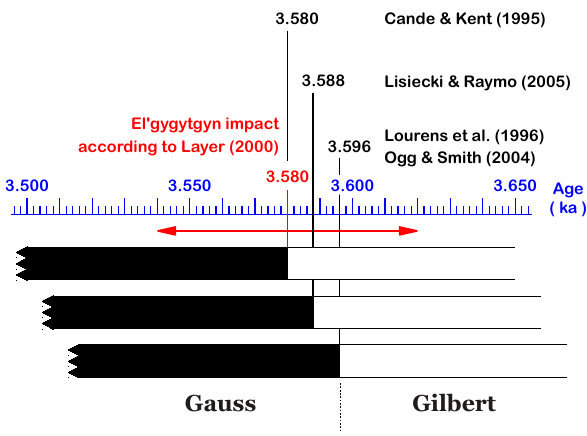
Fig. 9. Radiometric dating of the El’gygytgyn impact (Layer, 2000) in the context of currently used geomagnetic polarity timescales. Since the lowermost ICDP Site 5011-1 sediments show clear nor- mal polarity directions, the impact must have occurred after the Gilbert Gauss